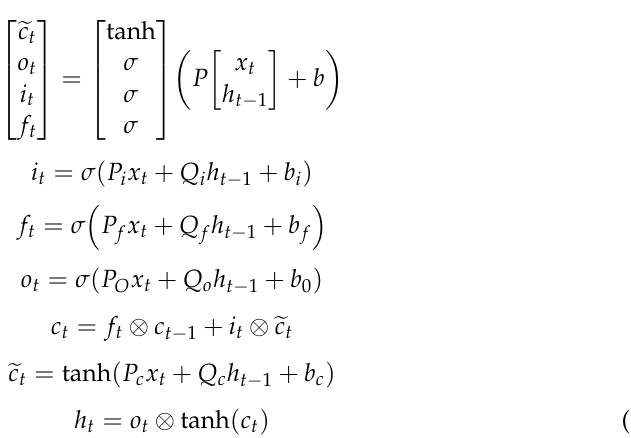
Figure 3. Cyclic unit construction of the LSTM network.